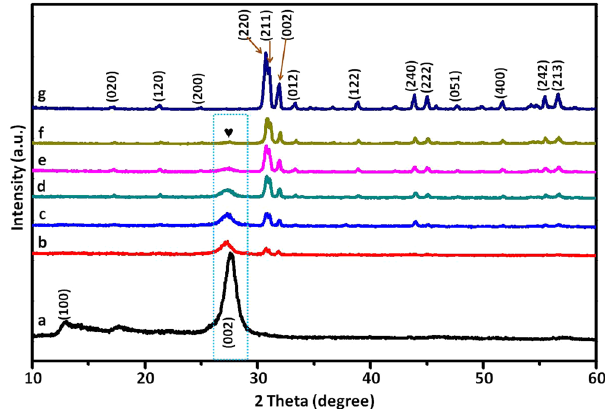
Figure 2. XRD patterns of ( a ) g-C 3 N 4 , ( b ) g-C 3 N 4 /Ag 2 CrO 4 (9.1%), ( c ) g-C 3 N 4 /Ag 2 CrO 4 (16.7%), ( d ) g-C 3 N 4 /